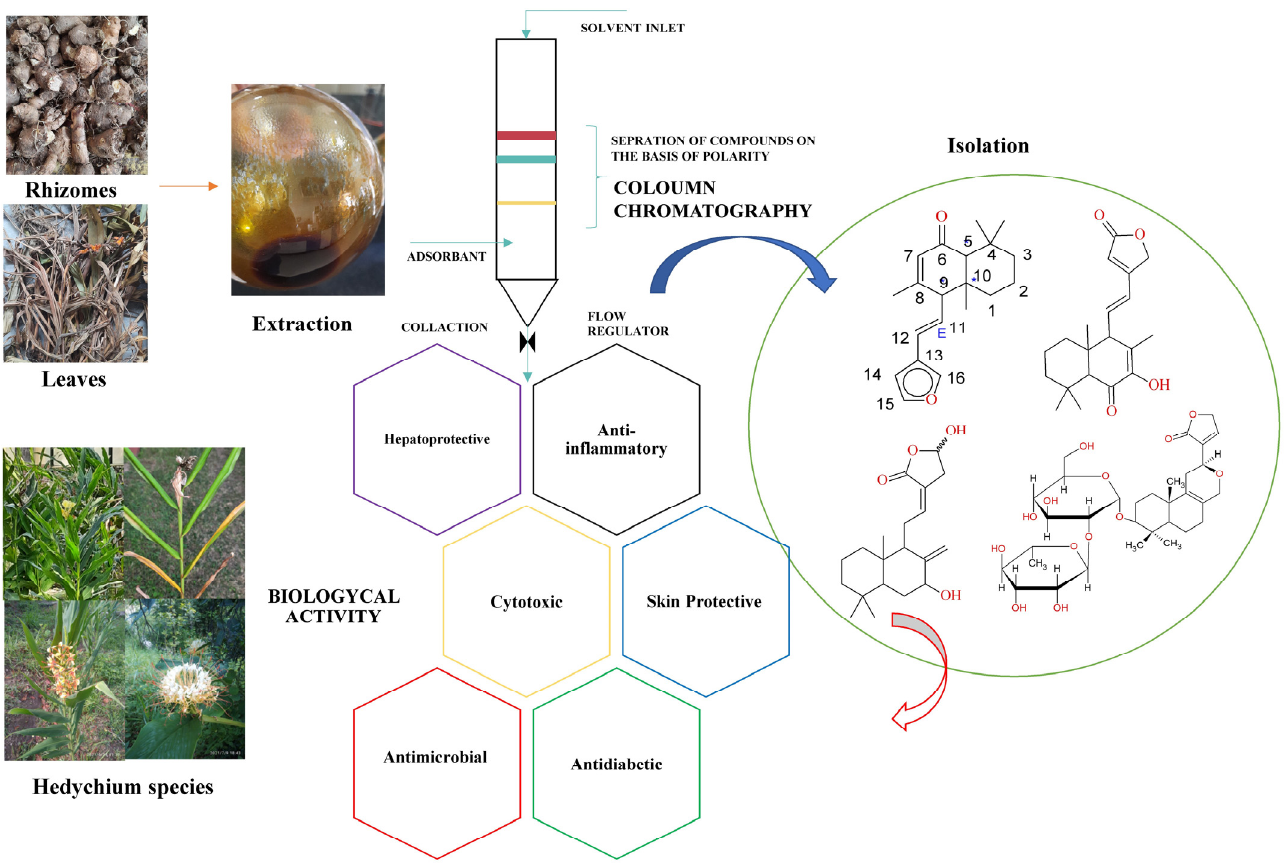
Figure 1. Screening of chemical constituents and pharmacological activity of phyto-extract from the leaves, rhizomes, and flowers of Hedychium species